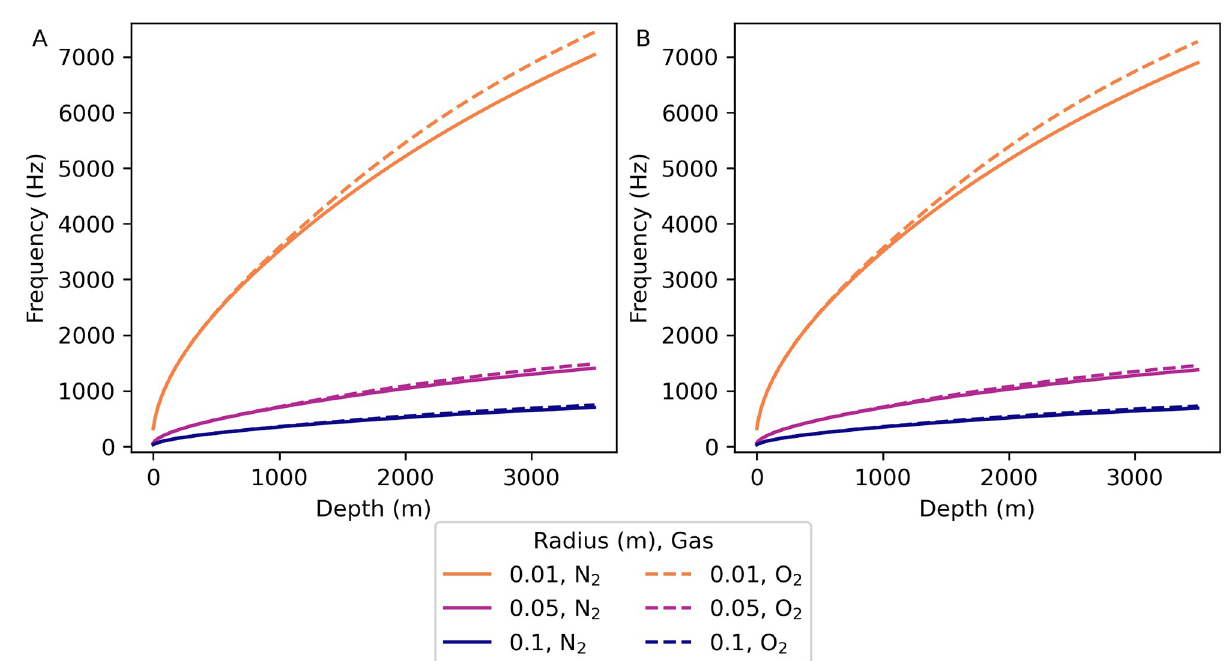
Fig 2. Bubble oscillation frequencies vs. depth. Frequencies calculated for nitrogen and oxygen bubbles of radii 0.01 m, 0.05 m, and 0.10 m for a 1.5˚C constant temperature, 35.0 g/kg constant salinity depth profile. Water and gas parameter values were calculated at 1 m depth intervals and interpolated between those depths. (A) Undamped bubble oscillation frequency f depth. See section 6 in S3 and S4 Files for the calculations used for this plot.